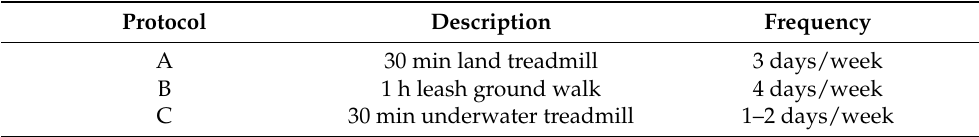
Table 1. Home Work Plan: Different types of